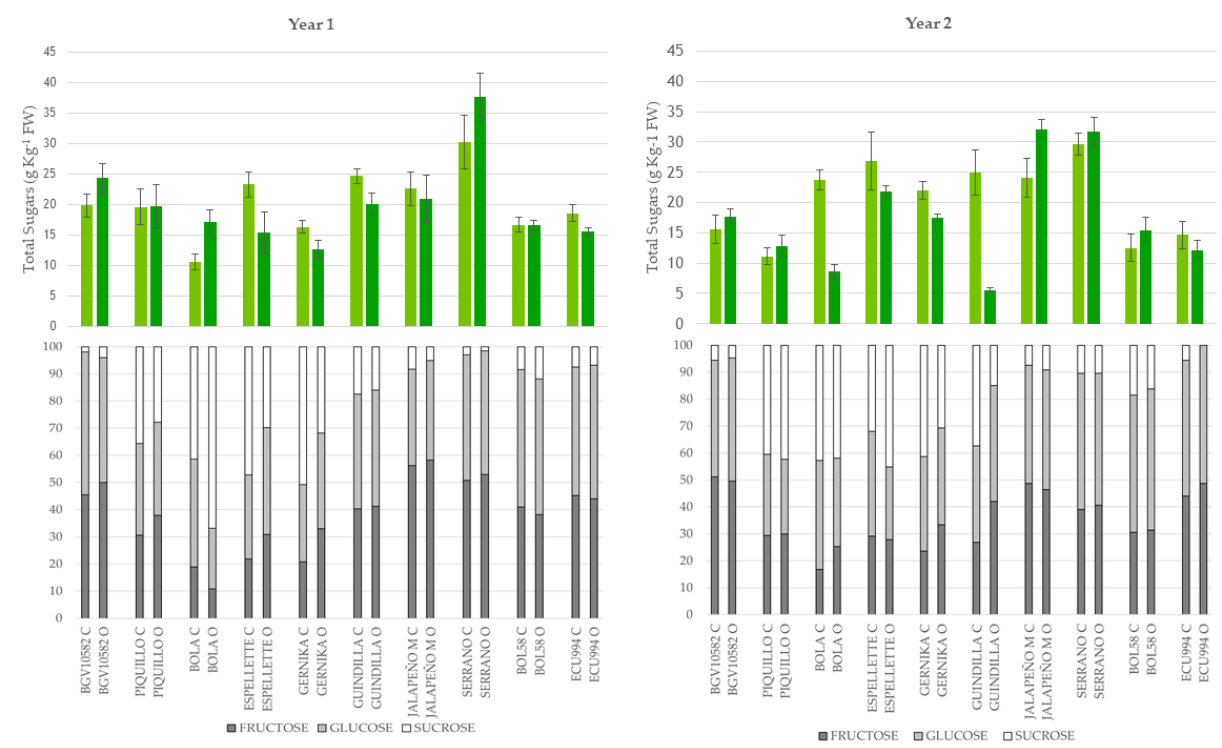
Figure 1. Content of total sugars (upper, g kg − 1 of fresh weight) and sugar profile (lower, % of total sugars, grey = fructose, pale grey = glucose, and white = sucrose) at the green-ripe stage for the accessions evaluated under conventional (pale green or C) and organic (green or O) growing conditions in years 1 and 2. Vertical bars in the upper figures indicate SE intervals for each mean value.